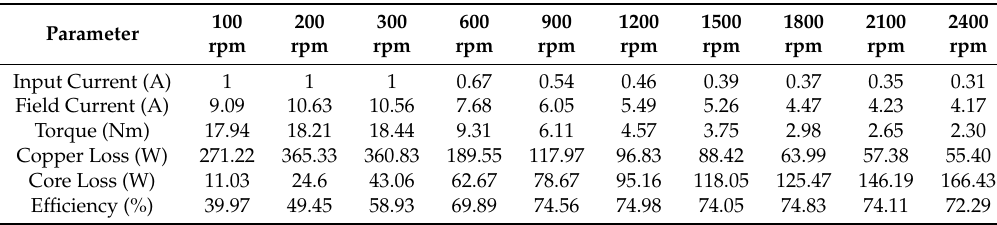
Figure 13. Rotor field winding currents for different speeds. Table 4. Wide-Speed Performance of BL-WRVM.